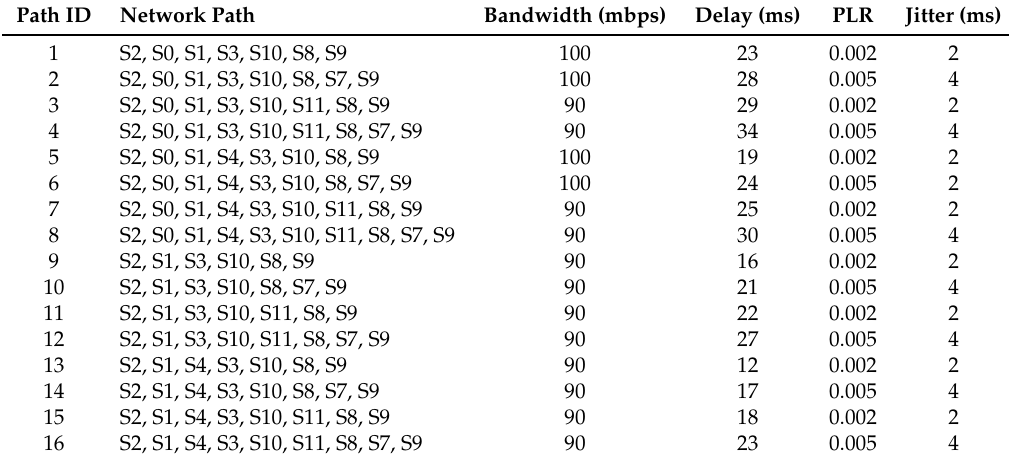
Table 4. Available network paths from Hosts 2 to 5 in the simulation model.